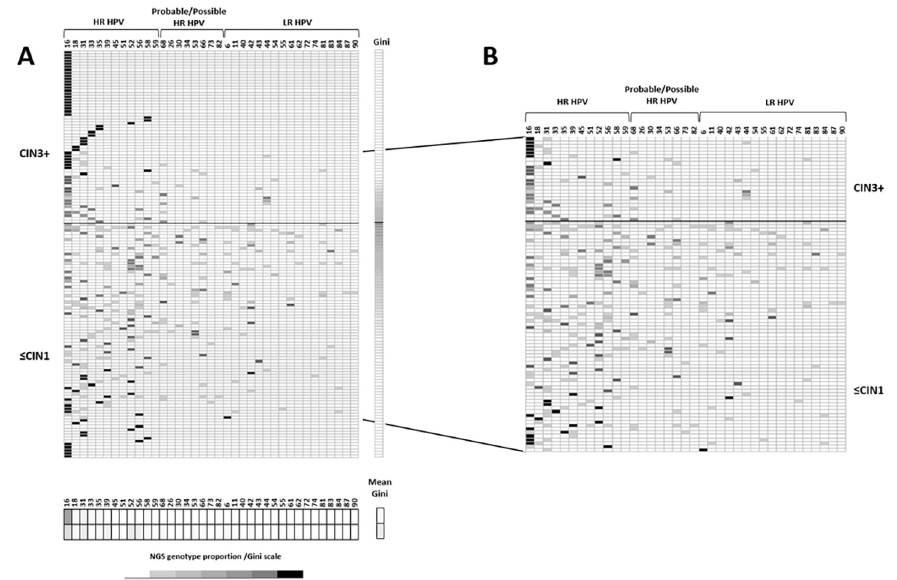
Fig 4. HPV genotypic diversity and relative proportion of HPV genotypes in cervical samples by NGS, according histology. HPV genotypes were classified according IARC criteria from carcinogenic (Group 1), probably/possibly carcinogenic (Group 2A/B) to probably not carcinogenic (Group 4). Lines correspond to each of the studied samples, the columns to each genotype identified and the different shades of gray in the cells represent the relative proportion, in percentage, of each genotype detected within a sample (the lightest corresponding to the lowest proportion and the darkest to the highest proportion). A: Individual and mean Gini coefficient to measure genotypic diversity are shown for each sample and histological group, respectively (79 � CIN1 and 58 CIN3+). Samples grade are ordered by Gini coefficient, from minimal (white) to maximal (black) genotypic diversity. B: Zoom in showing the HPV genotypic relative proportions in 92 cervical samples (68 � CIN1 and 24 CIN3+) with multiple